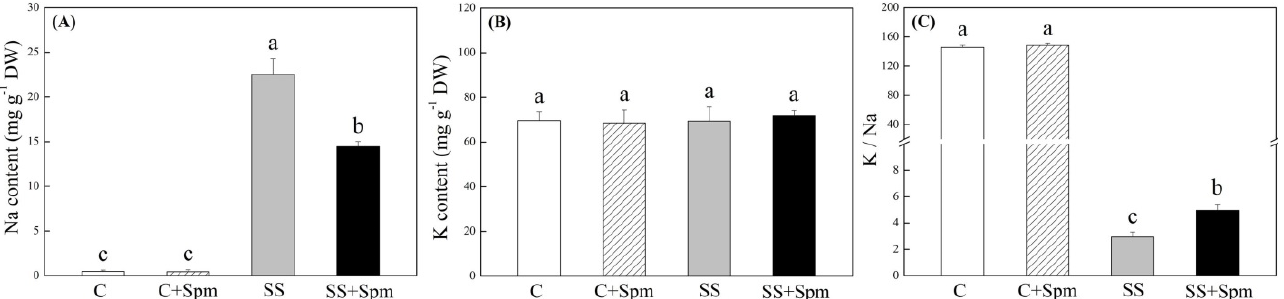
Figure 3. Effects of exogenous application of spermine (Spm) on ( A ) total antioxidant capacity (TAC), ( B ) hydroxyl radicals ( ∙ OH), ( C ) carbonyl content, and ( D ) electrolyte leakage (EL) under normal conditions and salt stress. Vertical bars indicate ±SE of mean (n = 4). Different letters above columns indicate significant differences based on LSD ( p < 0.05). C, control; C + Spm, control + Spm; SS, salt stress; SS + Spm, salt stress + Spm.